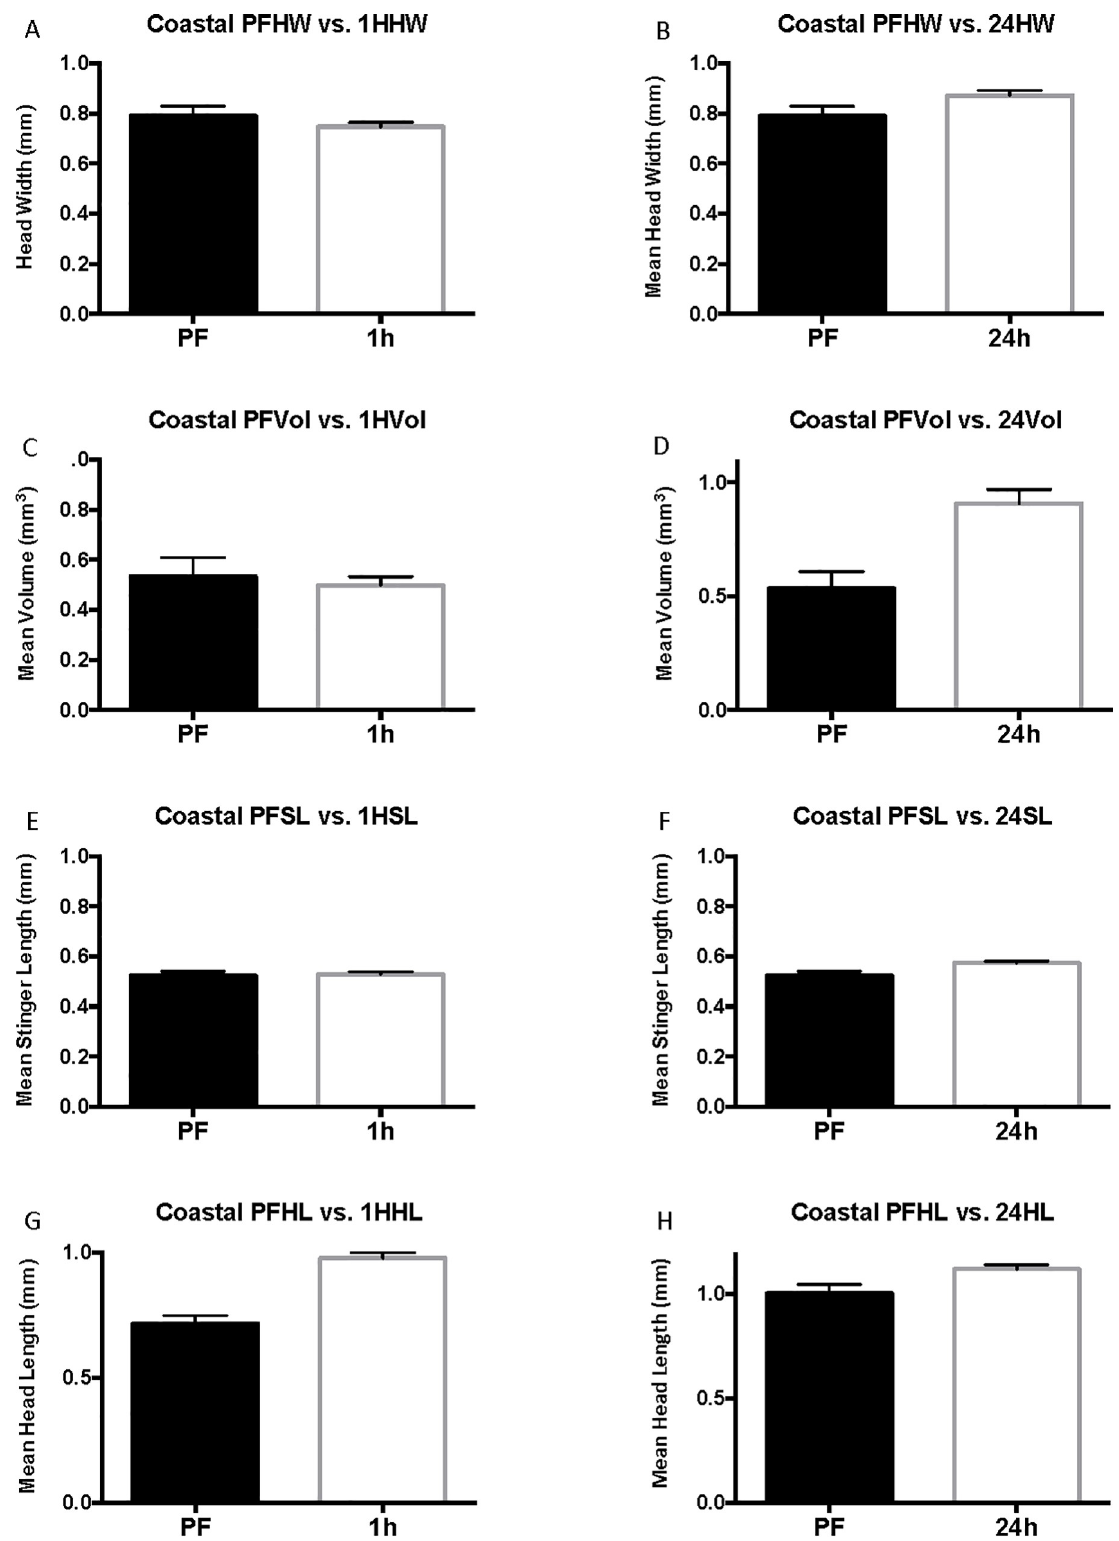
Fig 2. Complete coastal results. Mean head width (HW), mean stinger length (SL), and mean head length (HL) are reported in mm. Mean volume is in mm 3 . The error bars represent standard error of the mean. PF refers to pre-flood cohorts, 1h refers to 1-hour cohorts, and 24h refers to 24-hour